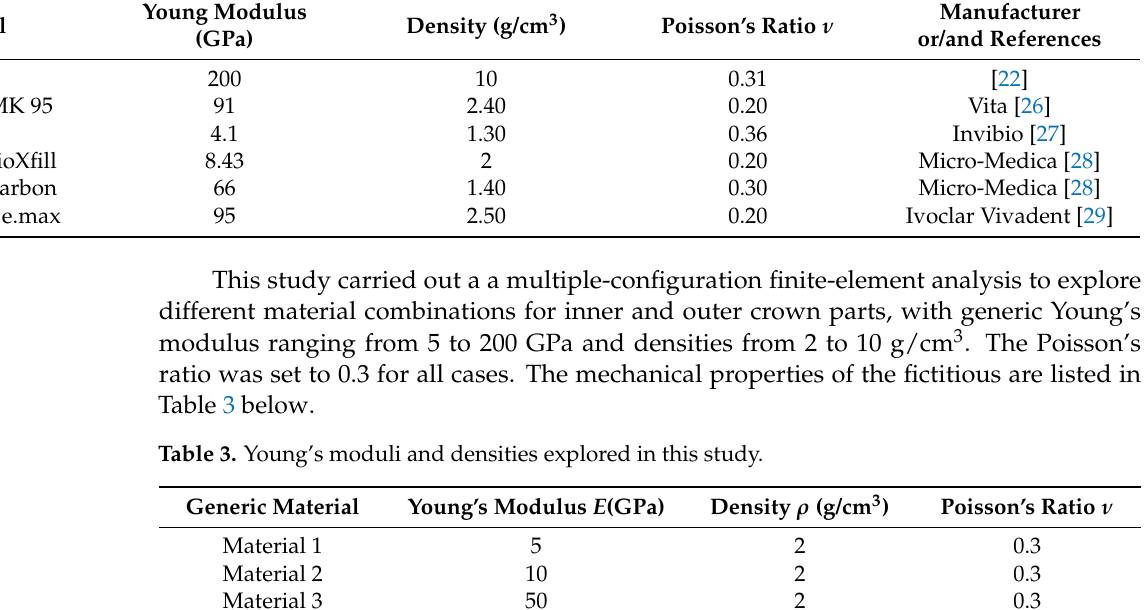
Table 2. Mechanical properties of the crown materials. Table 1. Common combination of materials for inner and outer crowns.